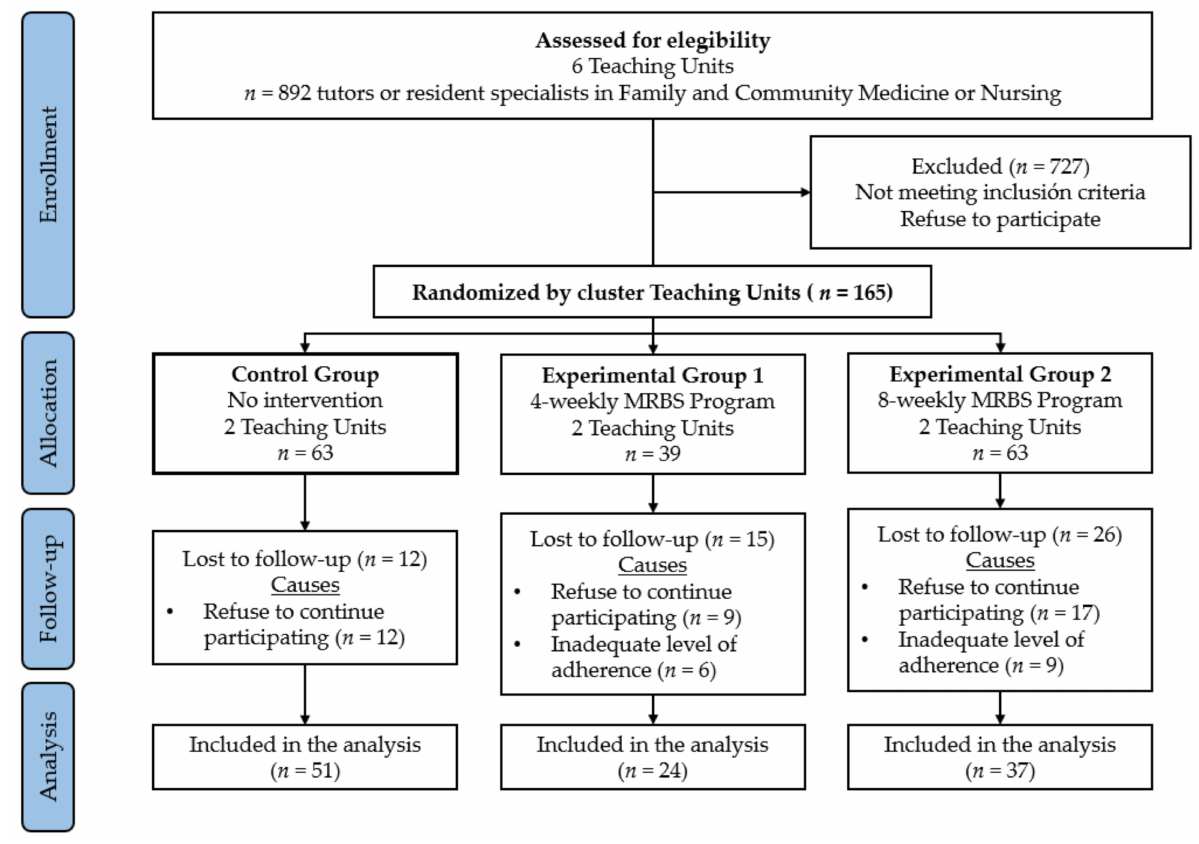
Figure 1. Flow participants’ chart through the